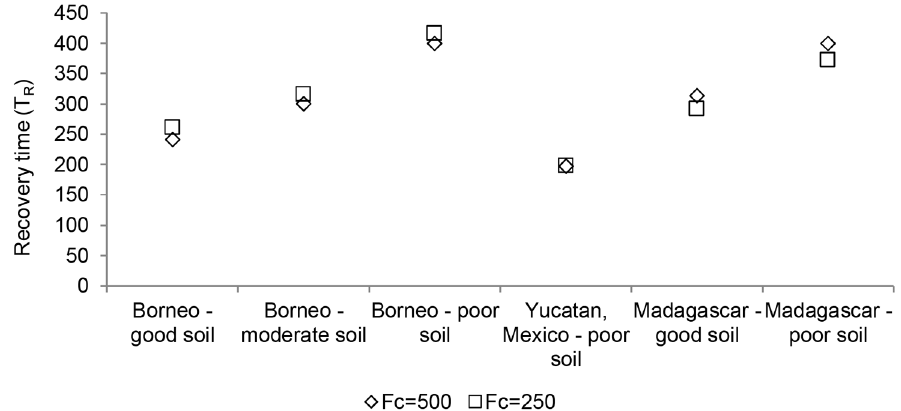
Fig 8. Comparison of recovery times following a standardized disturbance from two forest state starting points. The first starting point is a fully forested landscape ( F c = 500) which, by definition, has no agricultural pressure; the second is a landscape where the forest condition is at half its maximum possible value ( F c = 250). The level of agricultural pressure in the F c = 250 case depends on the specific parameter values that result in this forest state. The values of A corresponding to this forest state can be seen in Fig 7.